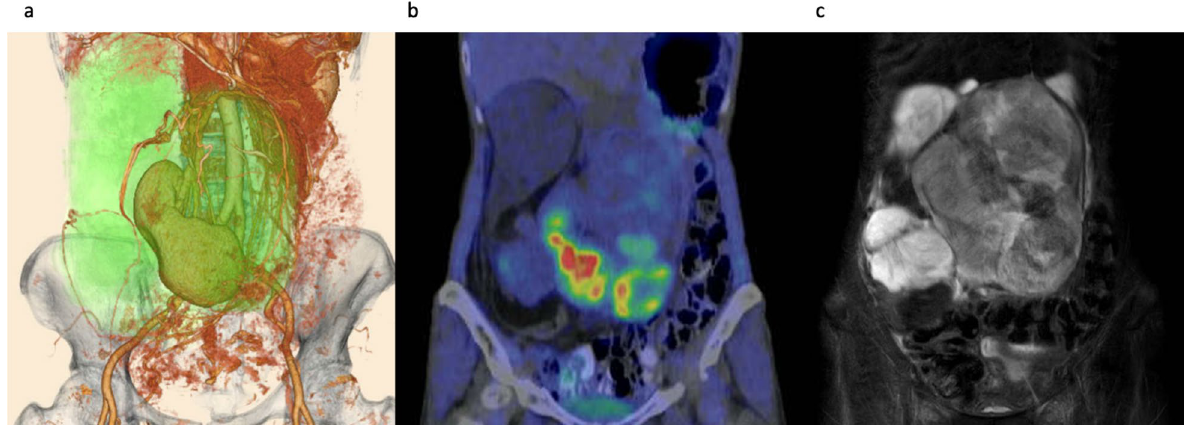
Fig. 1 Preoperative image. Three-dimensionl image of computed tomography reconstruction revealed retroperitoneal huge tumor surrounding right kidney (green area) ( a ). Positron emission tomography–CT showed a mixture of areas with and without fluorodeoxyglucose accumulation ( b ). T2-weighted magnetic resonance imaging showed a mixture of fatty and myxoid components ( c